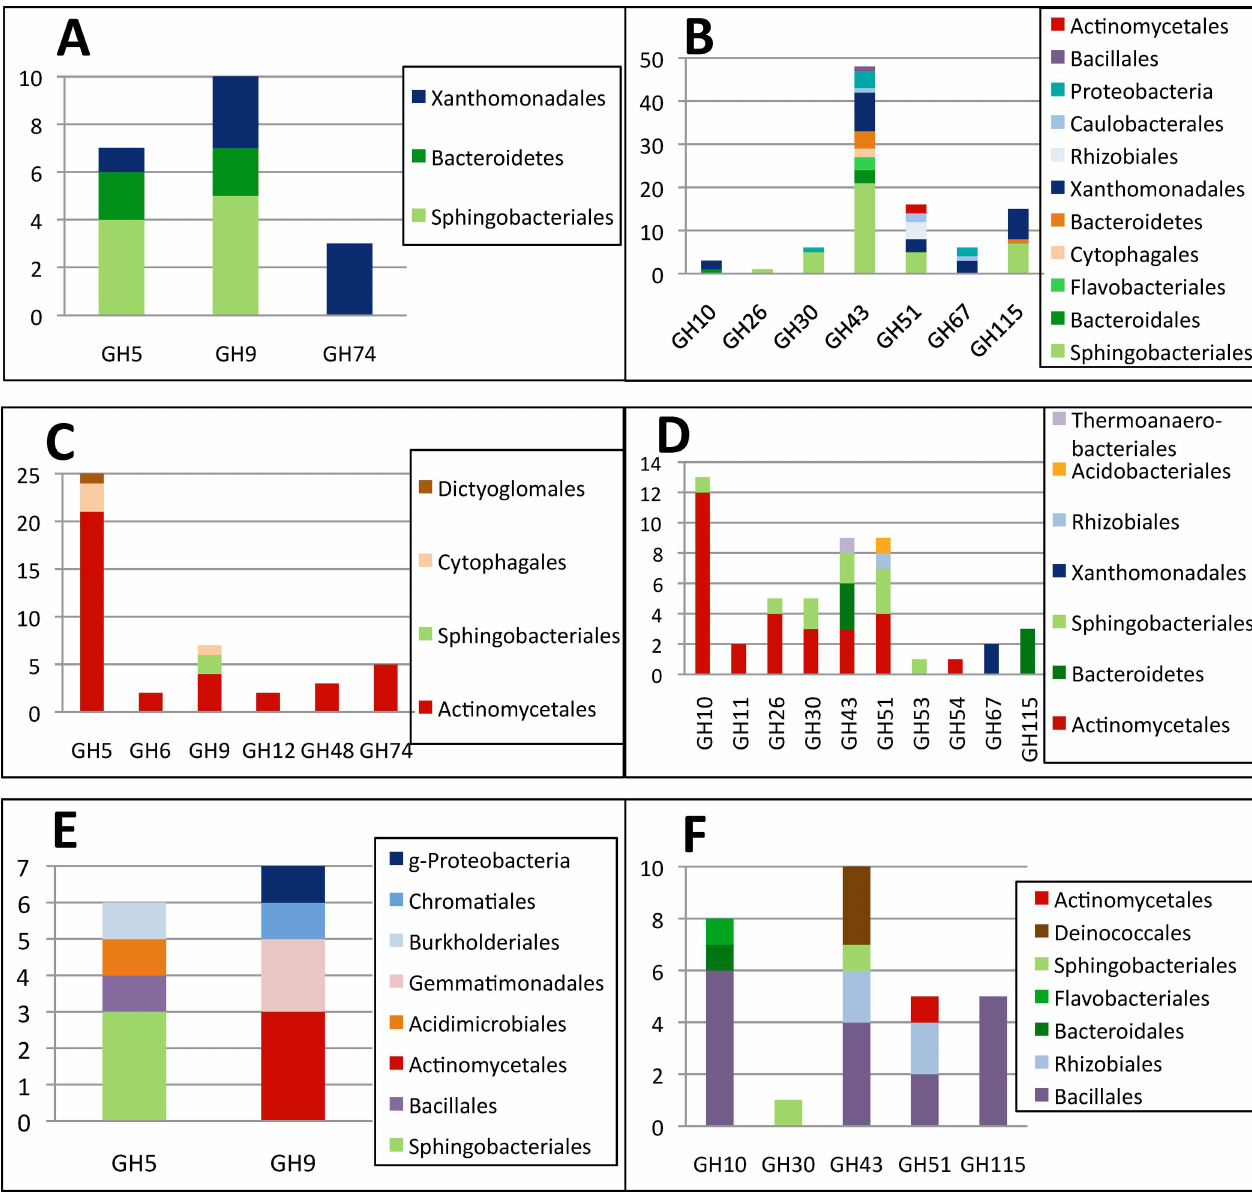
Fig 5. Assignmentof glycoside hydrolasefamilies with cellulaseactivities(panelA, C, E) and hemicellulase activities(panel B, D, F) to bacterial orders (or phylum level, if no order could be determined). Blastn analysisof contigs containing CAZymes of compost (A, B), LCB_s (C, D) and LCB_l (E, F) were realizedagainstthe non-redundant databaseand results visualizedby MEGAN software. Y axis represents the total gene diversity (number of hits with